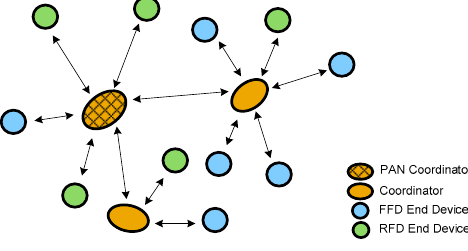
Figure 8. Cluster-tree network topology.